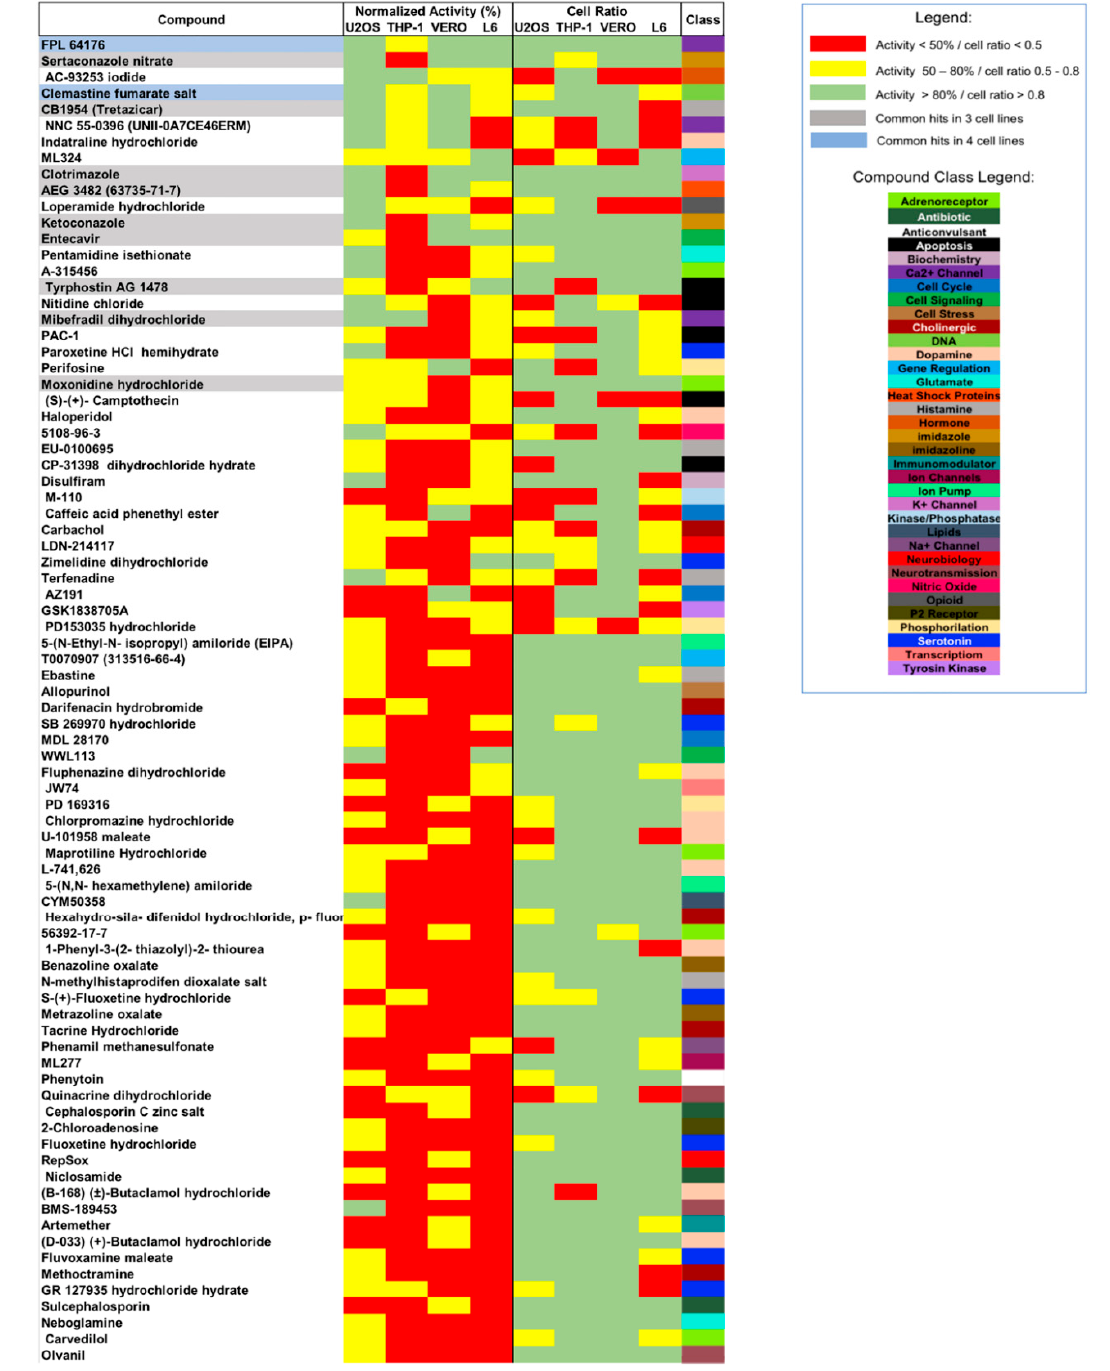
Figure 4. LOPAC 1280 library screening against T. cruzi infecting distinct cell lines: hit compound profiling. Normalized activity (left columns) and cell ratio values (right columns) for selected compounds assayed at 10 µ M against four cell lines infected with T. cruzi . Color highlighting indicates the range of activity / cell ratio: < 50% / 0.5 (red), 50–80% / 0.5–0.8 (yellow) and > 80 / 0.8 green. Grey highlighting in the compound list shows hit compounds selected in 3 cell line screens while light blue highlighting indicates selected hits common to all four cell line screens. The box on the right indicates the classification of hit compounds (according to library compound profiling) represented by the color code indicated in the legend box.